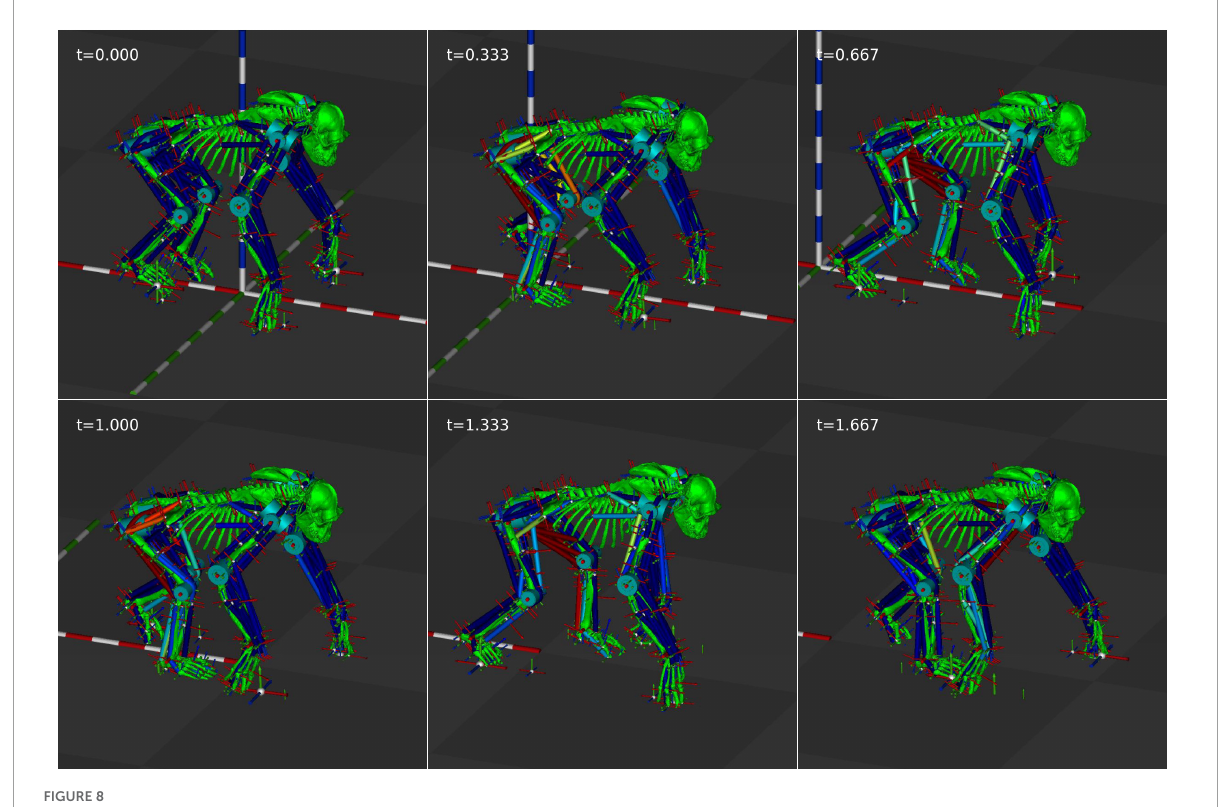
FIGURE8 Still frames from the efficiency optimized animation at 0.333 s